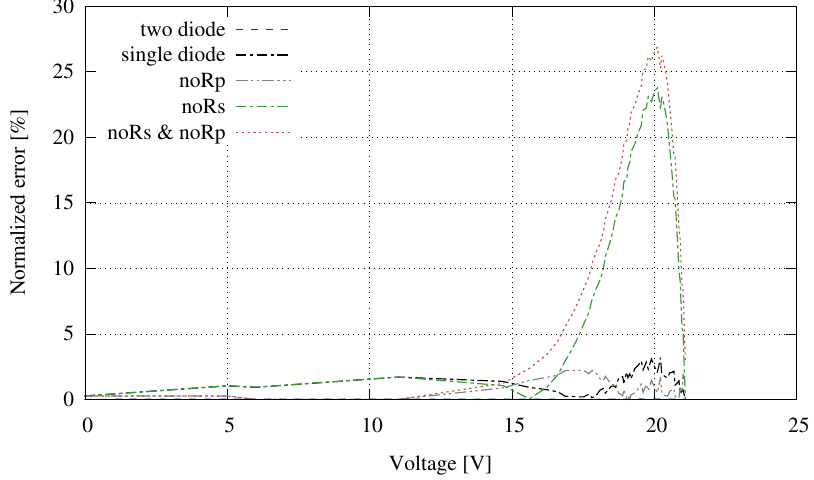
Figure 7. Normalized error obtained while reconstructing the Several I – V curve for Solarex MSX60 PV module with different model complexity.